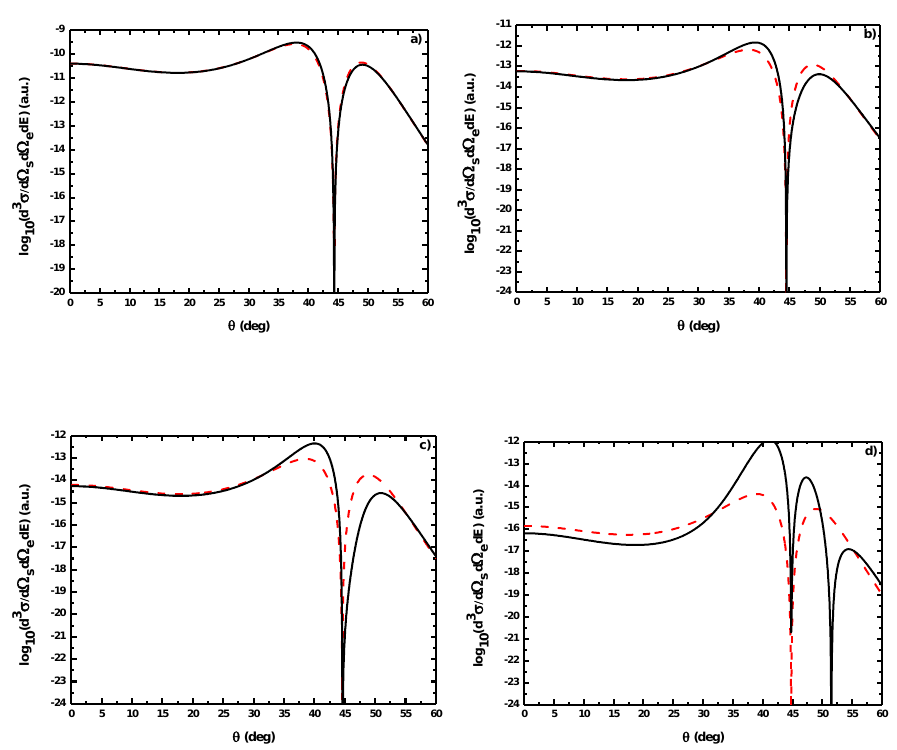
Figure 21. Triple differential cross sections corresponding to laser-assisted electron-impact ionization of atomic hydrogen in the ground state for the case of a coplanar symmetric geometry as a function of scattering angle θ = θ s = θ e for the absorption of one photon ( (cid:96) = 1). The incident electron energy is = 500 eV, and the electric field strength is E = 10 7 V/cm. The laser polarization vector is taken to E k 0 i be parallel to the transfer momentum ∆ . Solid lines: First Born approximation results. Dashed line: results obtained by neglecting the dressing of the target by the laser field. ( a ) The laser photon energy is ω = 2.347 eV; ( b ) ω = 4.95 eV; ( c ) ω = 6.42 eV and ( d ) ω = 9.9